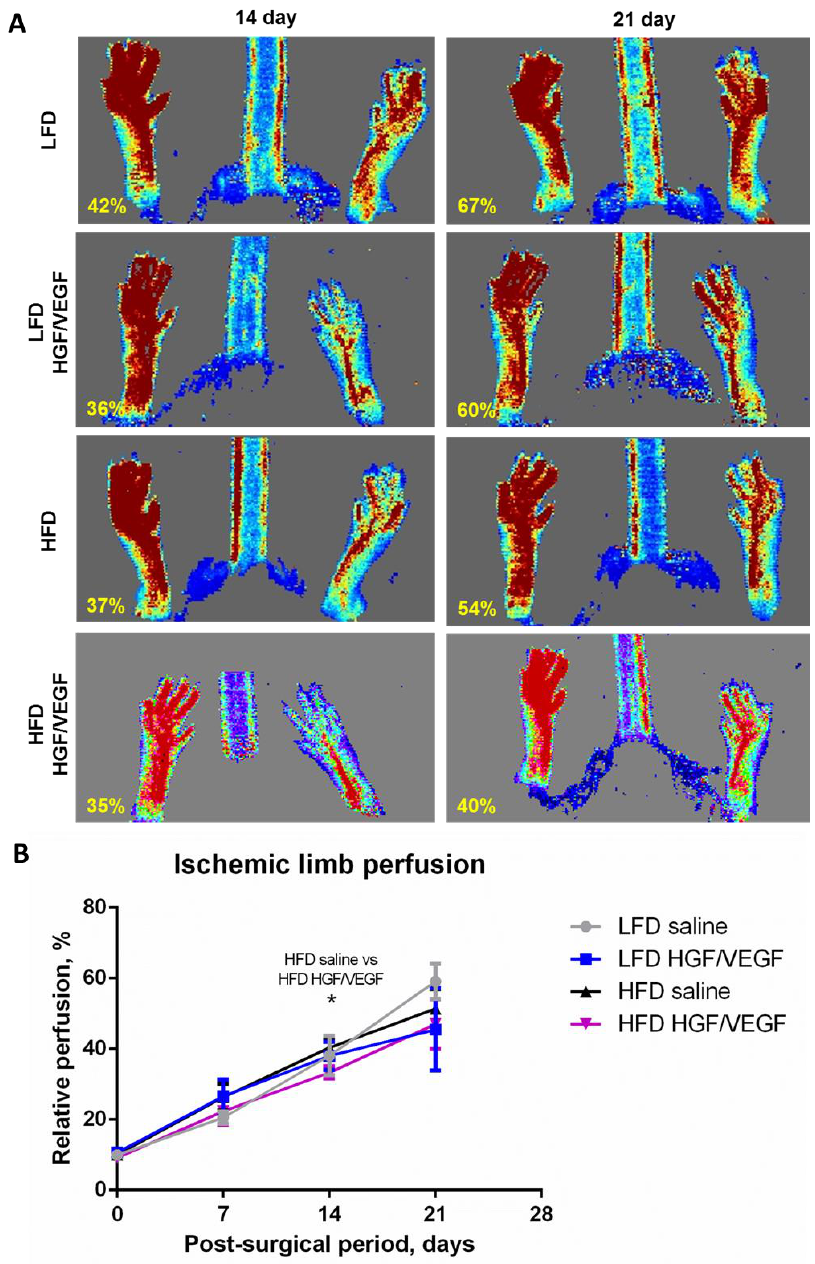
Figure 3. HGF/VEGF plasmid injection induces a transient delay of blood flow recovery in HFD group. (10+3 weeks of experiment). ( A ) representative Laser Doppler scanning images subcutaneous blood flow in experimental groups; ( B ) dynamics of blood flow recovery after HGF/VEGF therapy under LFD or HFD dietary intervention. Data is presented as mean ± SEM; Kruskal – Wallis test with post hoc Dunn’s test; * p < 0.05.